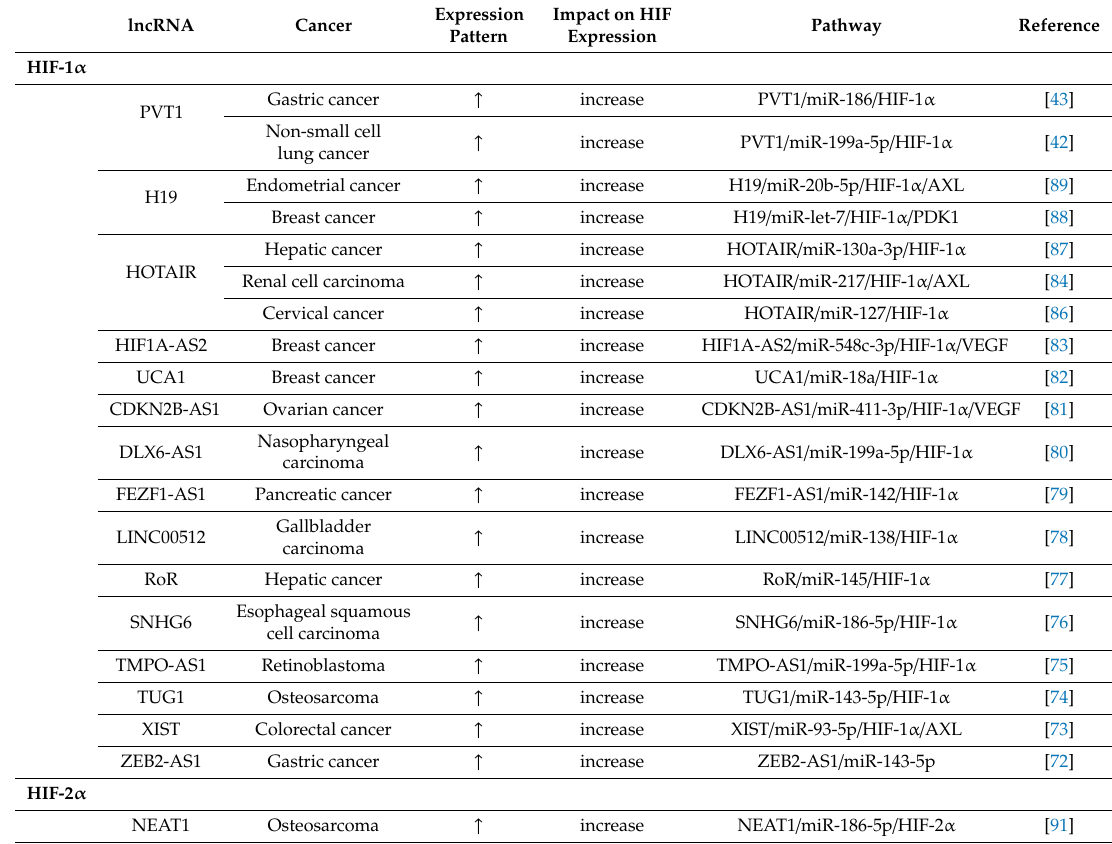
Table 2. Competing endogenous RNAs in the regulation of hypoxia-inducible factor.